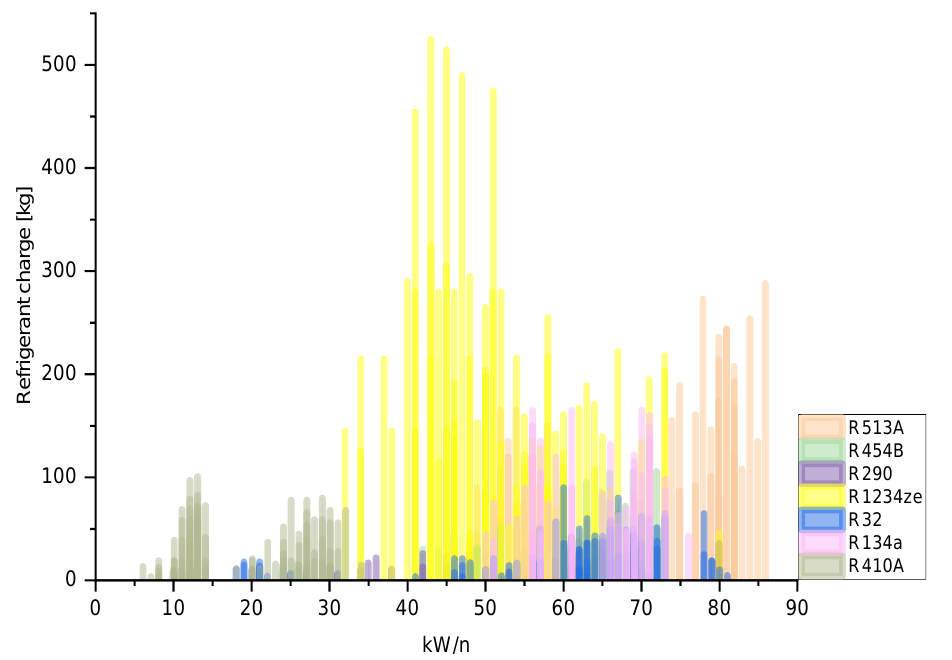
Figure 3. Dependence of the refrigerant mass in the device on kW/n for the selected refrigerants. In the range of 5–30 kW/n, devices filled with refrigerant 410A and R32 dominate. In turn, from 40 kW/n to more than 85 kW/n, the R1234ze, R134a, R454B, R513A, and R290 refrigerants dominate. The largest charge (load greater than 100 kg) is found in devices with R513A, R1234ze, and R134a, with R1234ze dominating with loads exceeding 500 kg. Charges not exceeding 100 kg refer to the refrigerants R454B, R32, R290, and R410A. It is worth paying attention to the small loads (<50 kg) of refrigerants throughout the range of the kW/n ratio for R290. For Q/mr ratio, the highest values are for R290 (6.5–18 kW/kg), R410A (5–13 kW/kg) and R134a (5–11 kW/kg). As a result, higher charges for similar power are required for other investigated refrigerants. The lowest ratios are observed for R513A and R32. To calculate CO 2 equivalent emissions for refrigerants, it is necessary to know the GWP index for each refrigerant and for a specific time horizon. Therefore, in Figure 4, GWP 20 and GWP 100 index values for selected refrigerants and their components are presented.